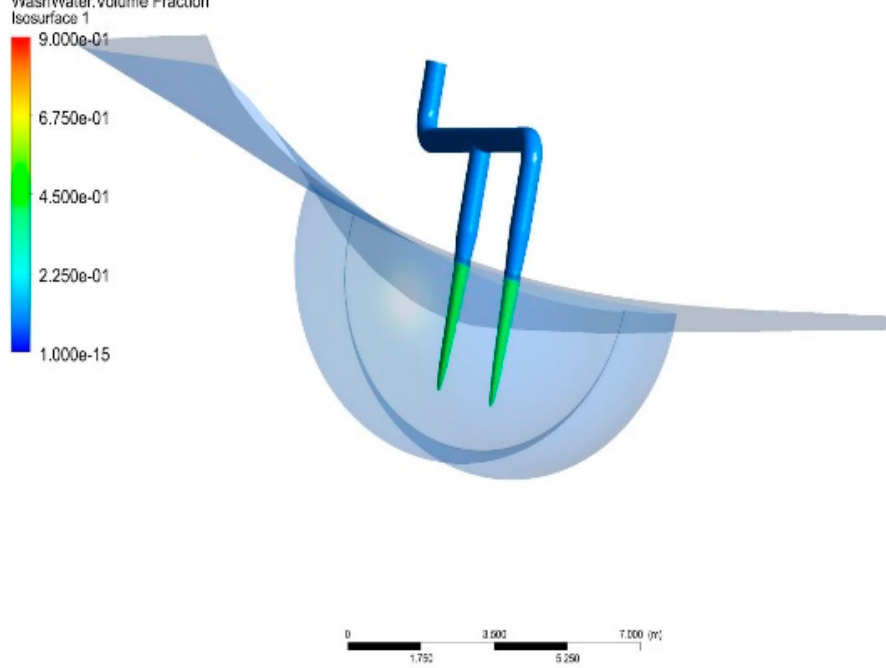
Figure 20. Scrubber Wash Water Volume Fraction of 0.43 isosurface development.